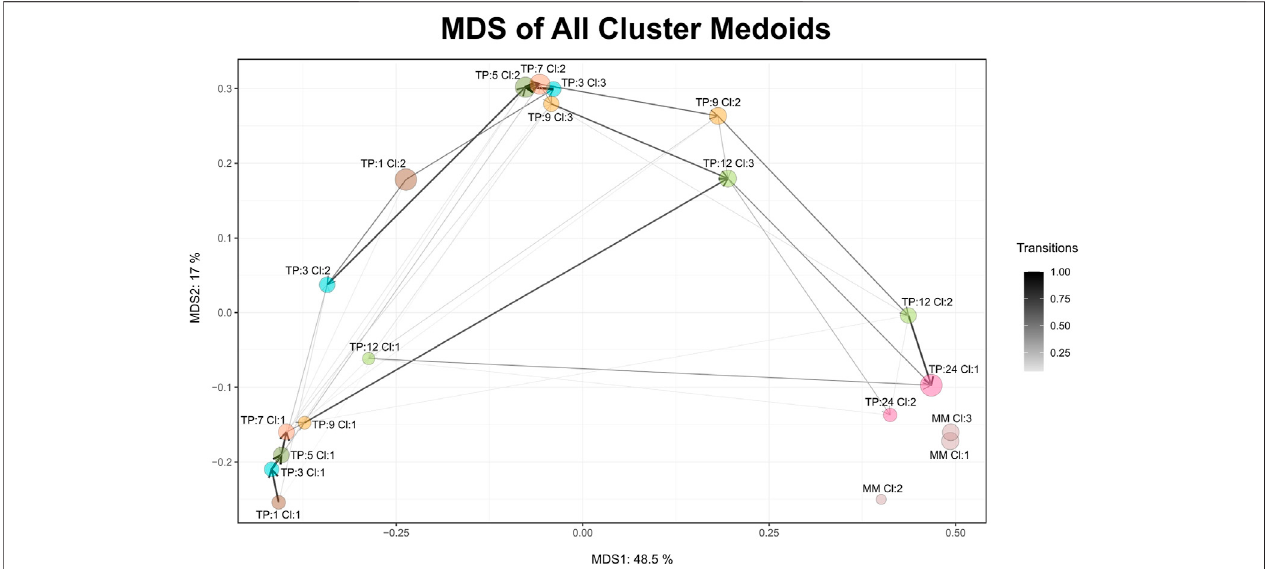
FIGURE3| MDSgraph ofclustermedoids ofallclustersonalltimepoints and theexternalreferenceasproduced byCronos. TPrepresentsthetime point and CL the cluster. MM abbreviation stands for mature microbiome and refers tothe externalreferencesamples. Circle sizeis relative tothe percentage ofthe samplesfound to belong in the cluster, whereas the connecting arrows are directed from the earliest to the latest time point and their width is relative to the percentage of the samples following the transition.